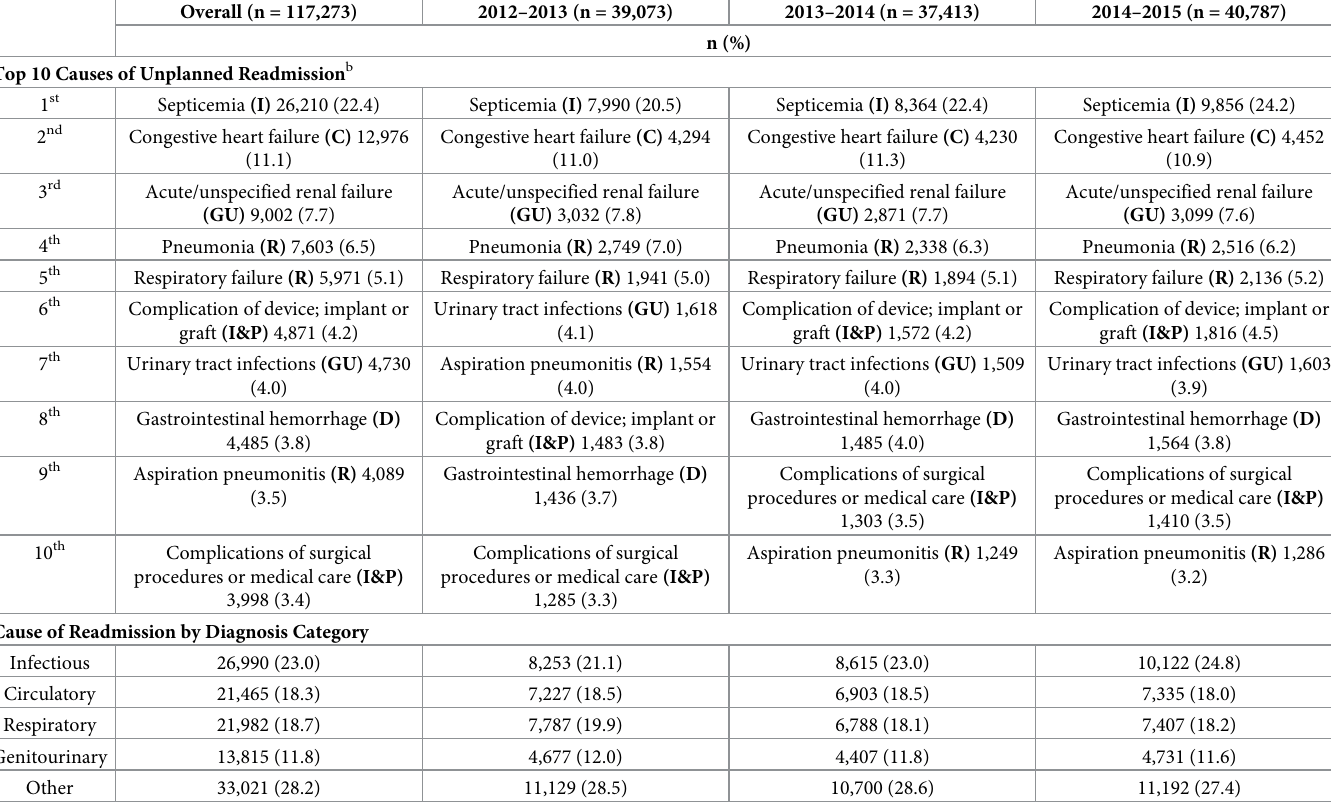
Table 3. Causes of 30-day unplanned hospital readmission among older adults discharged to skilled nursing facilities Following an index hospitalization for sepsis, 2012–2015 a